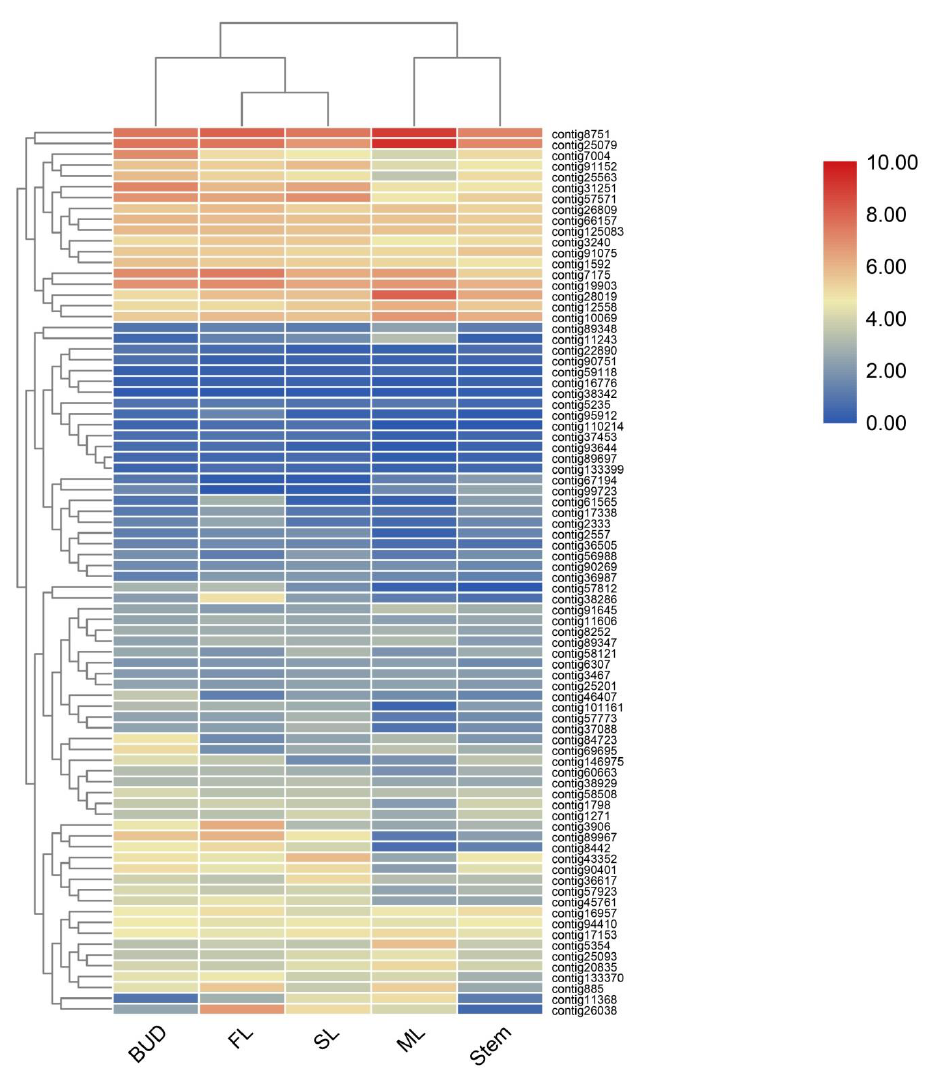
Figure 3. A heatmap coupled with clustering analysis of 82 terpenes related genes in five tissues of tea plants. ML, mature leaf; SL, the second leaf; FL, the first